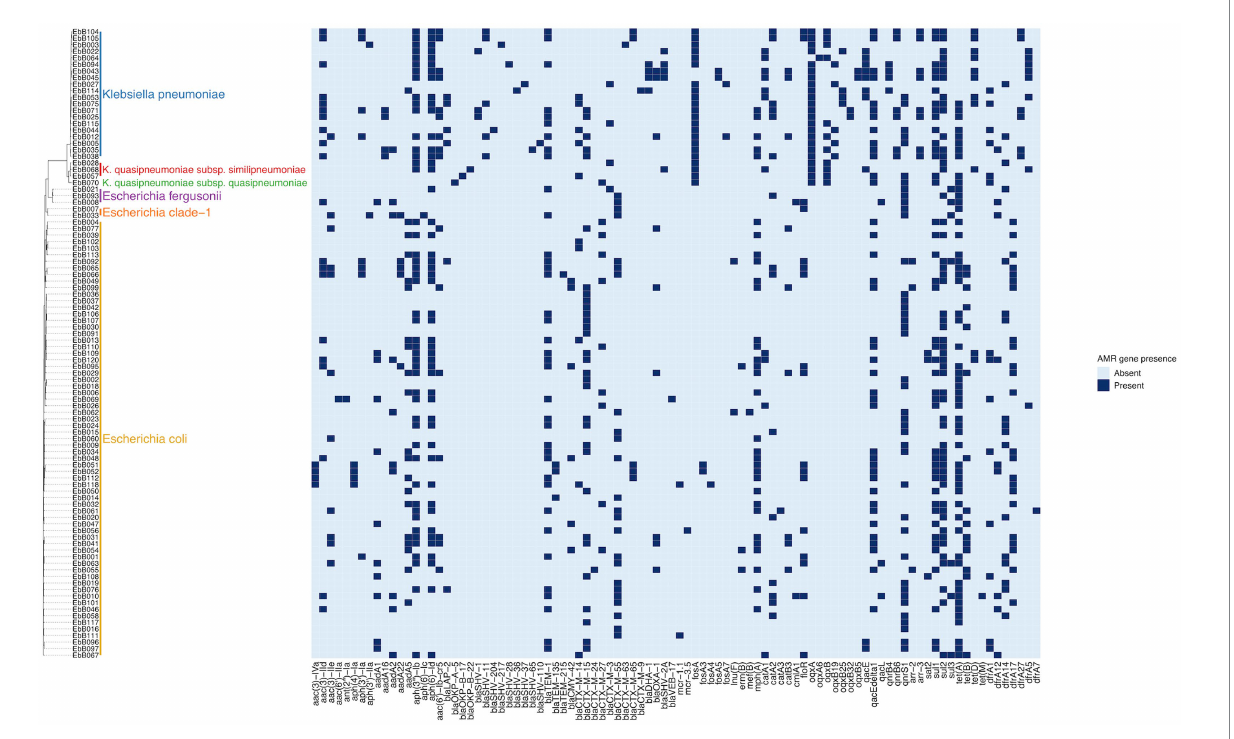
FIGURE 2 Phylogeny based on mashtree of all samples showing species, and presence of selected AMR genes in each